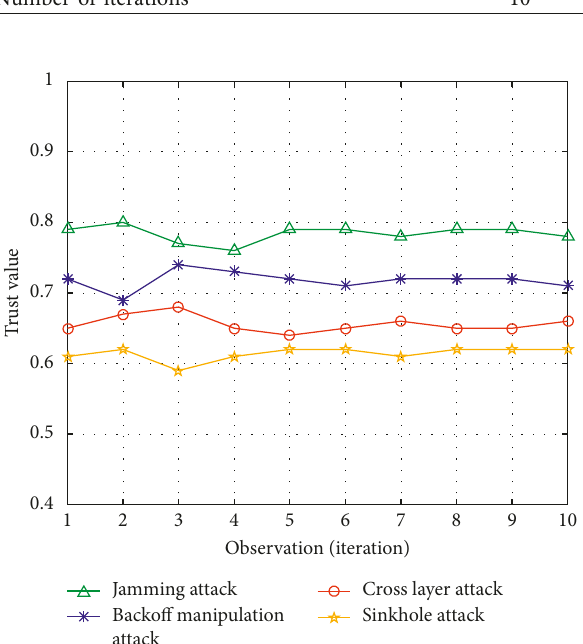
Figure 9: Trust values at different types of attacks.